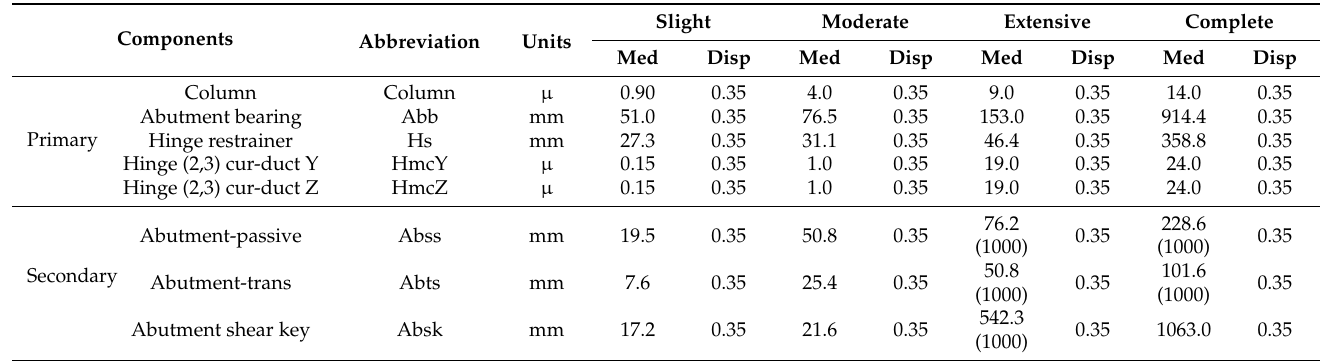
Table 1. Limit state models for the bridge components.